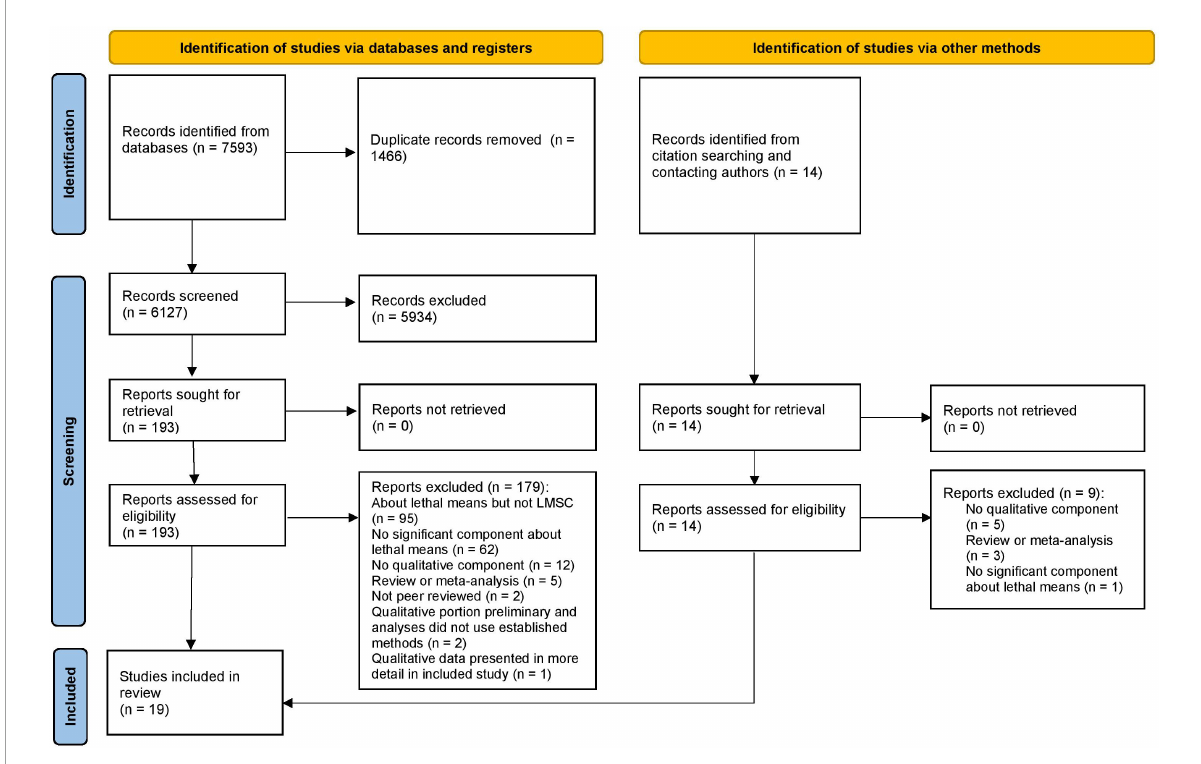
FIGURE1 PRISMA flow diagram for study identification, screening, and